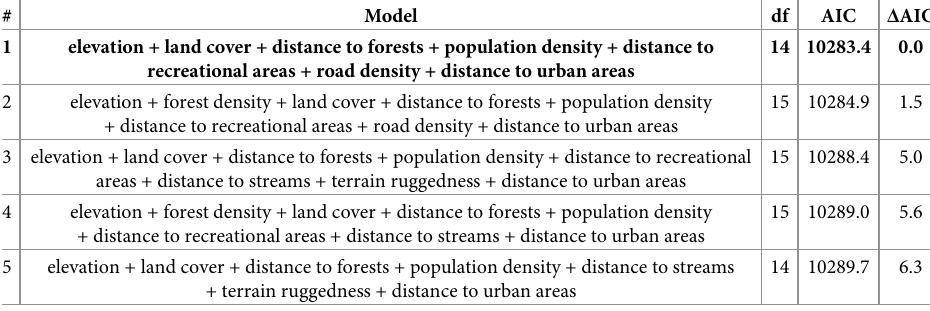
Table 2. The five “best” RSPF models, based on AIC